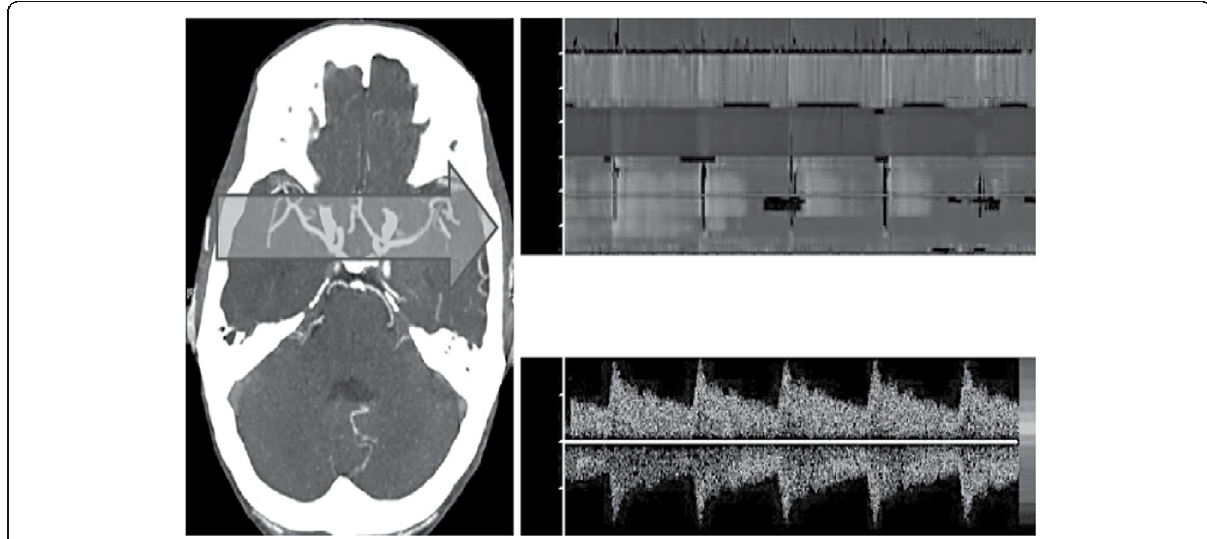
Fig. 1 Transcranial insolation of anterior circulation. Power-mode multigated transcranial Doppler (TCD) employs 2 MHz ultrasound that penetrates the entire diameter of the skull ( a ). In an average adult skull, midline is believed to be at 75 mm. Thus, the flow signals obtained from beyond 75 mm are from contralateral arteries